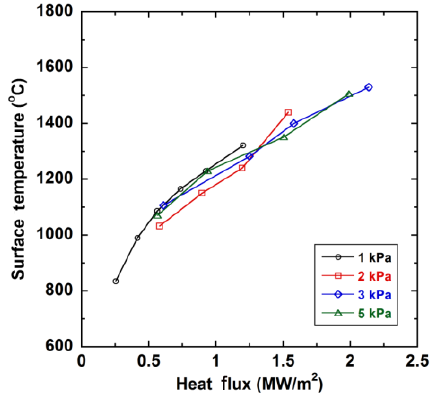
Fig. 3 Evolution of surface temperature of C f /SiC with heat flux in the plasma wind